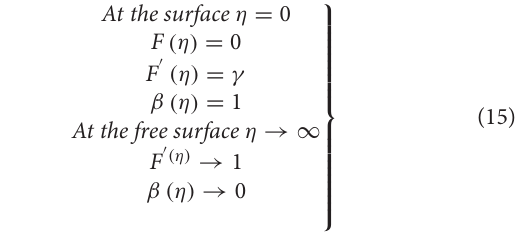
TABLE 1 | Thermal and Physical Properties [29]. Host fluid and nanoparticles